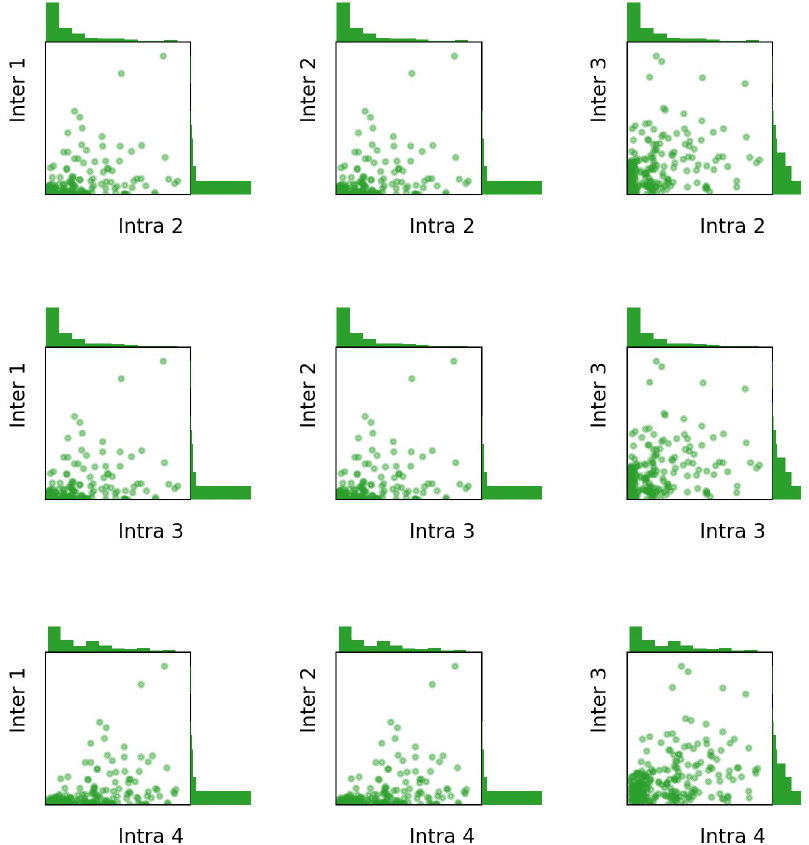
Fig 3. All pairs of trade-offs between Intra- and Inter-fairness from 250 trials of formulation Intra 5 + Inter 3 (L). Each trial uses distinct batch of jobs and its parameters ( γ 1 , γ 2 ) uniformly vary from (0.5, 0.5) to (0.9, 0.1) with the interval of 0.1. Each dot in a subplot represents the values of the corresponding Intra- and Inter-fairness measured post hoc for the result of one trial. The histograms on the top and the right sides show the distribution of the Intra- and Inter-fairness among the 250 trials, respectively.